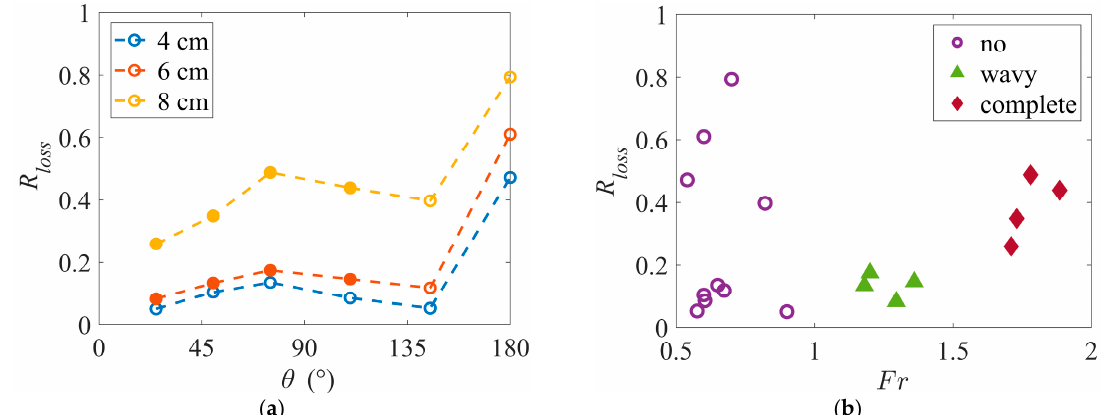
Figure 10. Variations in energy loss rate R loss with ( a ) canyon angle (hollow symbols mean that no internal hydraulic jump occurs) and ( b ) maximum Froude number.